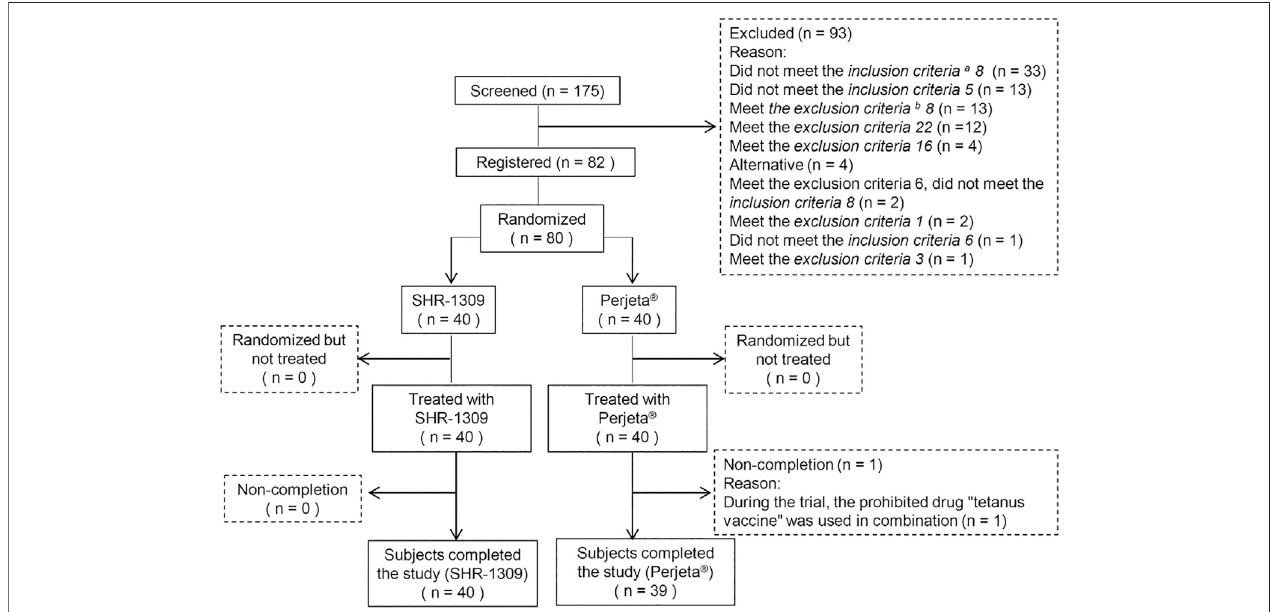
FIGURE 1 | Subject fl ow chart. n indicates the number of subjects. Exclusion indicates subjects who did not meet the inclusion criteria or who met the exclusion criteria. Replacement indicates that the subjects did not meet the criteria before drug administration. Non-completion indicates that the subjects did not complete all sample collections for some reason and were not included in the fi nal statistical analysis. a,b: the detailed inclusion criteria and exclusion criteria are shown in the supplementary fi le.